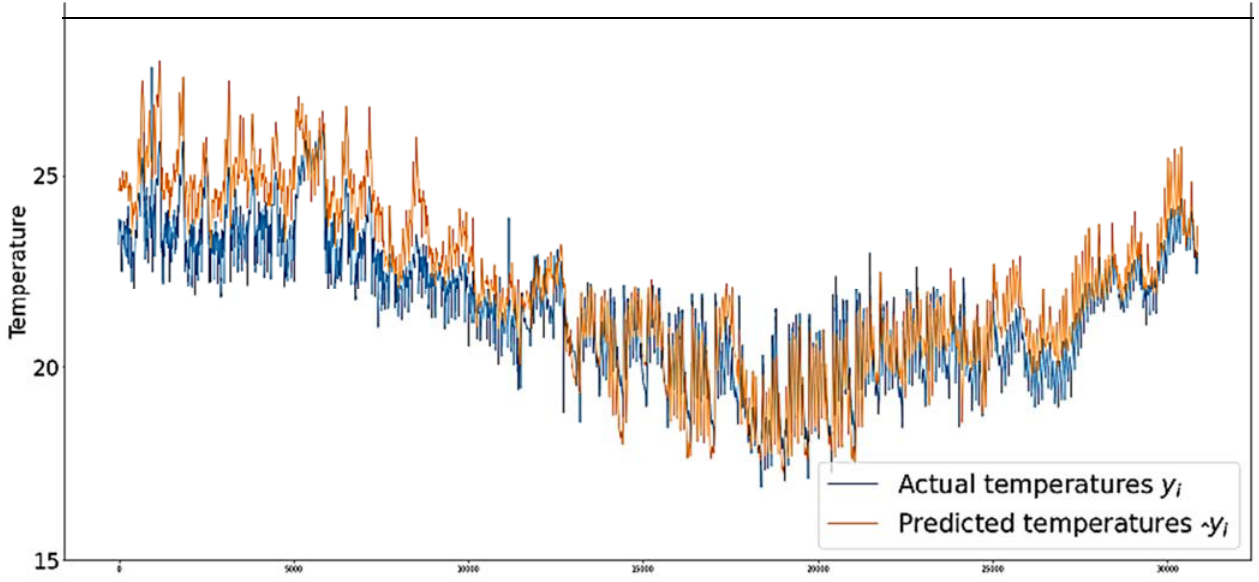
Figure 21. Plot of actual and predicted temperatures 24 h ahead for office 40 on the first floor.